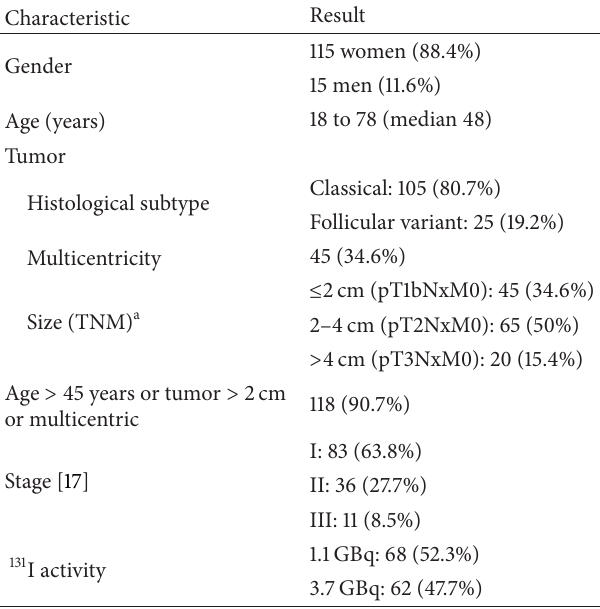
Table 1: Characteristics of the patients